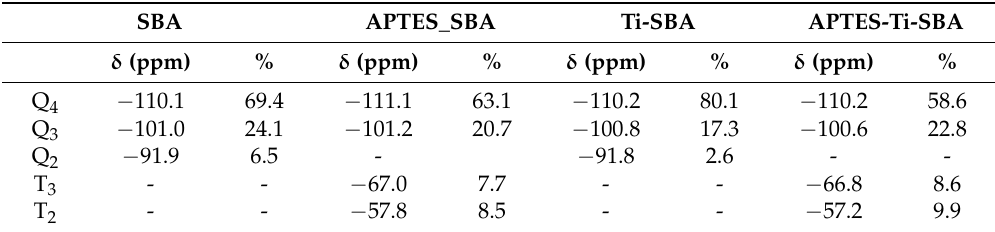
Table 2. 29 Si NMR band position and its